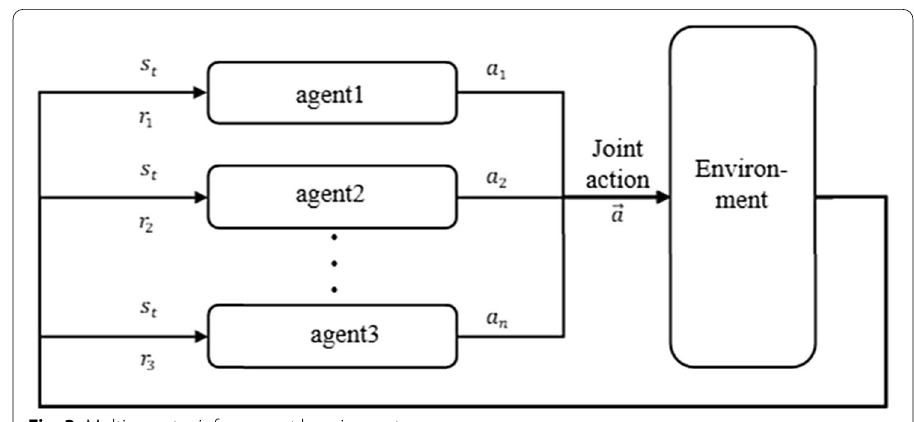
Fig. 3 Multi-agent reinforcement learning